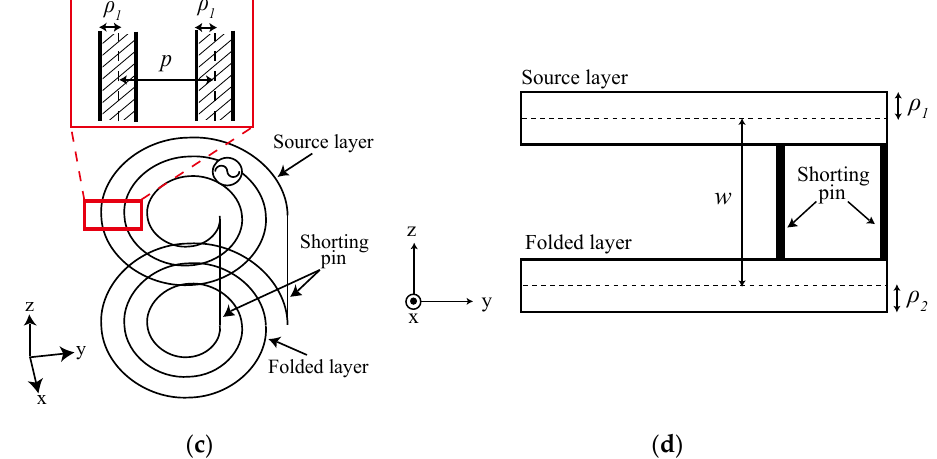
Figure 2. Structures: ( a ) spiral resonator; ( b ) folded spiral resonator with a single-layered structure; ( c ) bird’s-eye view of the folded spiral resonator with a double-layered structure; ( d ) side view of the folded spiral resonator with a double-layered structure.